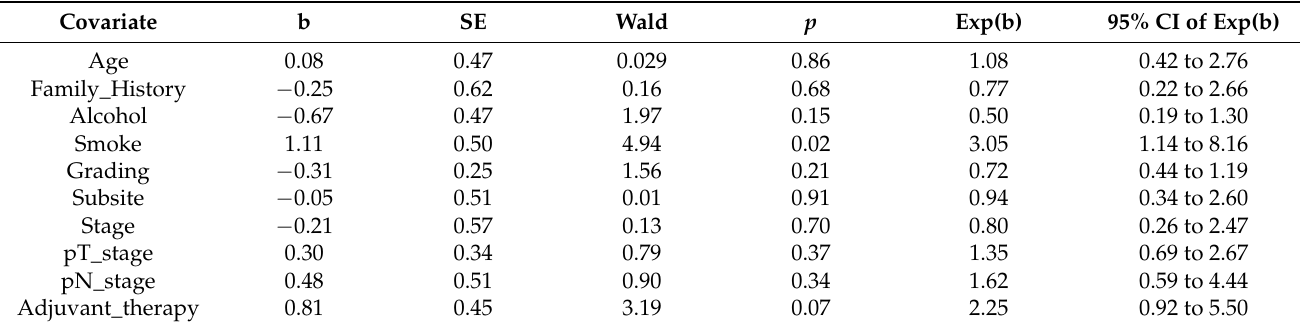
Table 4. Cox proportional-hazards regression analysis of the clinical-anamnestic data as risk factors on 5-years Disease Specific